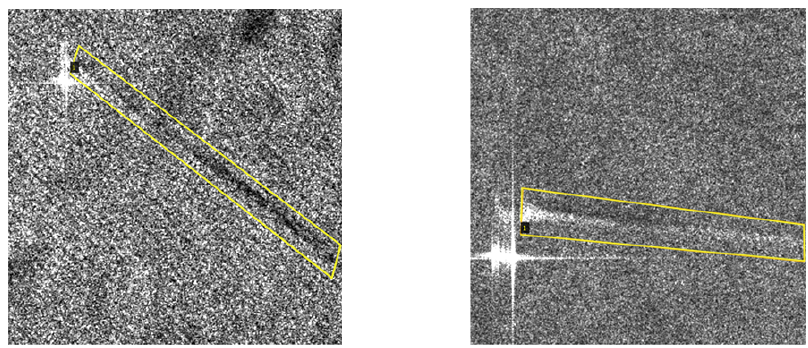
Figure 5. Polygonal mask annotations of ship wakes labeled using VIA